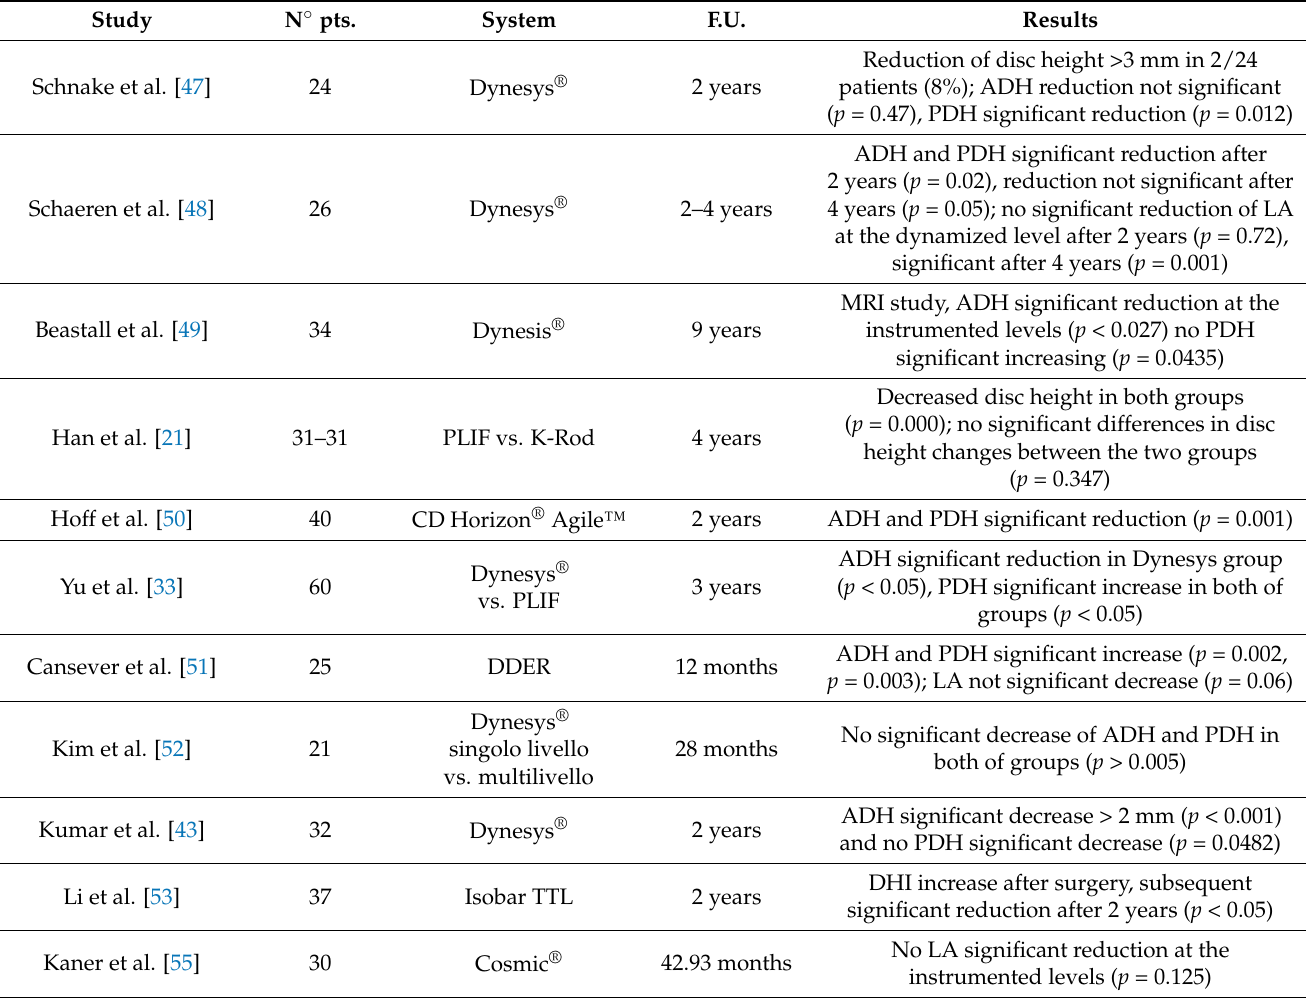
Table 3. Summary of the published reports on dynamic or hybrid